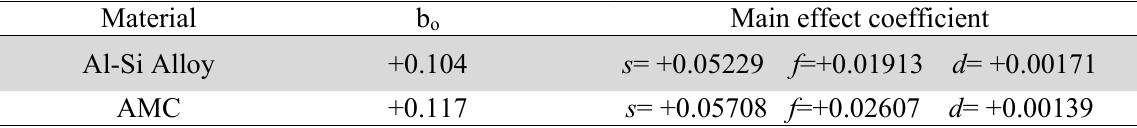
Regression equation coefficients for the alloy and composite (tool wear)